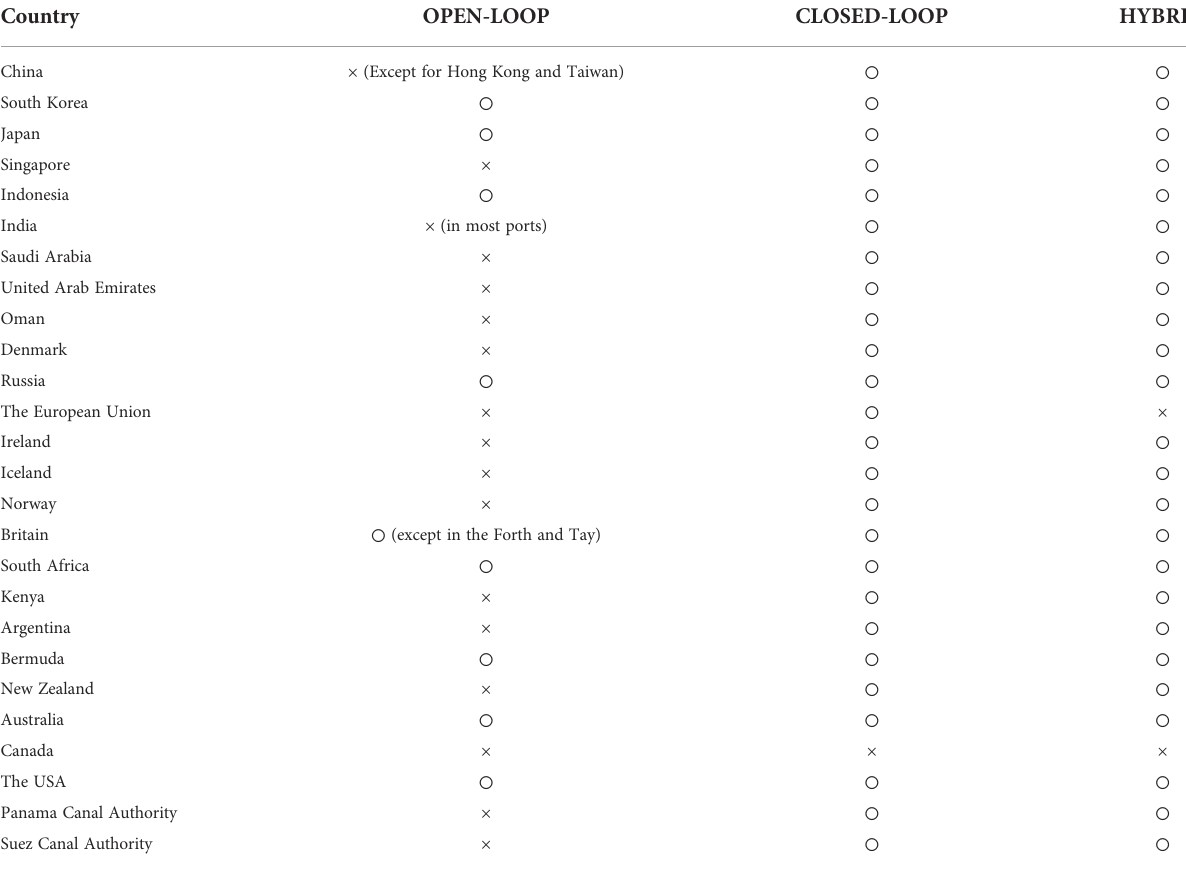
TABLE 3 Restrictions on the use of Scrubbers in various countries ( ○ for Acceptance, × for Non-acceptance). Country